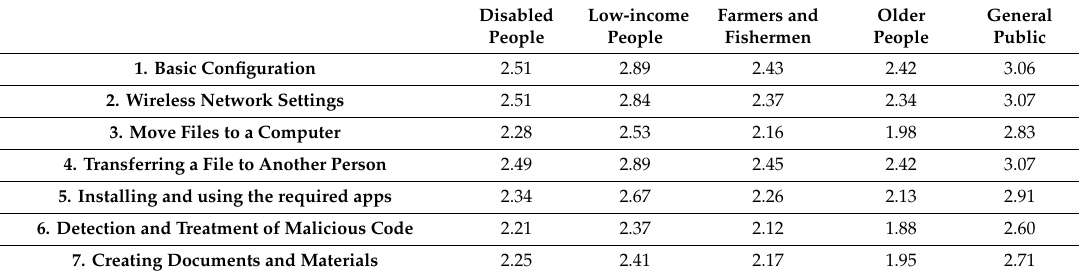
Table 12. Summary of mobile device usability of four